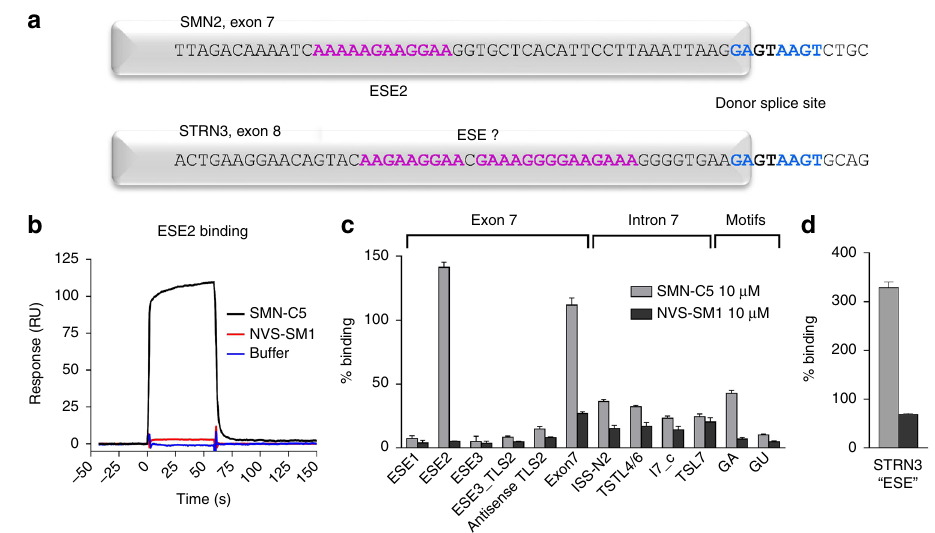
Fig. 4 SMN-C5 binds to the SMN2 ESE2 and the STRN3 “ ESE-like ” structure. a Schematic illustration of the ESE2 region in the SMN2 exon 7, and the putative ESE in the STRN3 exon 8 (indicated in pink). Note that the 5 ′ ss of these two exons are identical (in blue). b Direct binding analysis on a SPR system (Biacore 2000) to investigate the interaction between SMN-C5 or NVS-SM1 (10 µ M each) and buffer control, to the immobilized ESE2 RNA in the SMN2 gene. Representative sensorgrams from triplicate experiments are depicted. c Quantitative assessment of binding of SMN-C5 and NVS-SM1 (10 µ M each) to distinct RNAs in the SMN2 gene (ESE1, ESE2, ESE3, ESE3_TLS2, antisense_TLS2, Exon 7, ISS-N2, I7_TSTL4/6, I7_c, I7_TSL7, “ GA ” motif, and “ GU ” motif) immobilized on the SPR sensor. RNAs were captured via biotin on the streptavidin-coated sensor at surface densities in the range of 900 – 1200 RUs (response units). The SPR signals monitored for small molecules are normalized to the molecular mass. 100% binding corresponds to the amplitude of SPR signal monitored for binding of a small molecule to the RNA strand by full occupancy of one binding site (1:1 binding stoichiometry). d Binding to the STRN3 ESE-like region. Data in c and d represent means ± SEM of fi ve